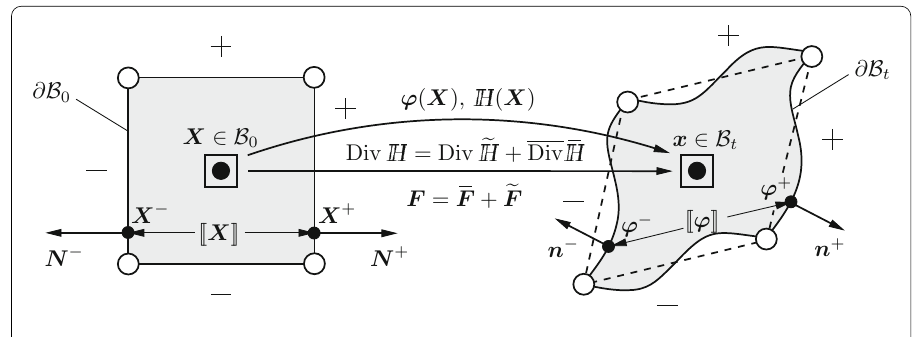
Fig. 2 Periodic boundary conditions associated with the minimization-based formulation of chemo-mechanics. The boundary of the RVE B 0 is split into B + N + = − N − = : N . At the respective material points X + and X − on these boundaries, the deformation map is considered to be periodic ( ϕ ( X + ) = ϕ ( X − )) and the normal solvent-volume flux H is considered to be anti-periodic ( H ( X + ) · N + = − H ( X − ) · N −